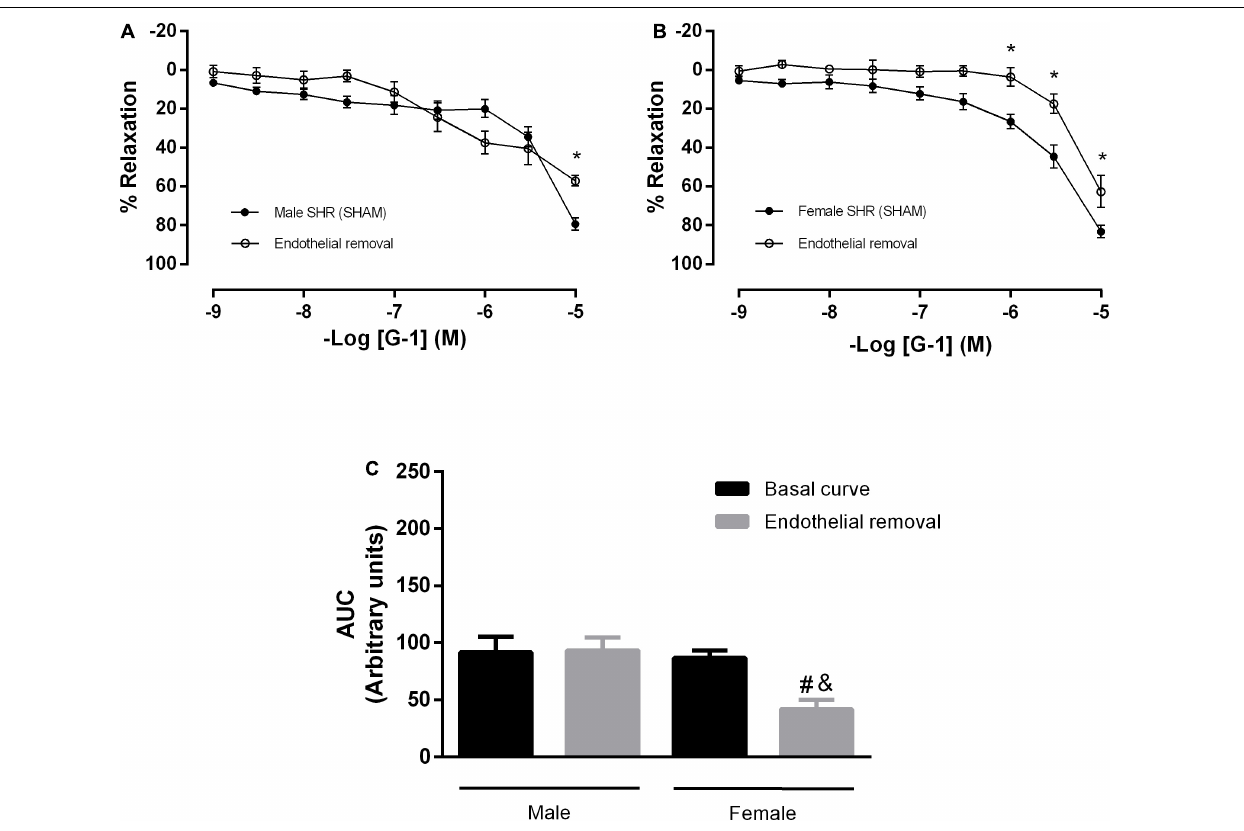
FIGURE 2 | The vasodilator response induced by G-1 is partially dependent on the endothelium in female SHR. Effect of endothelial removal on the relaxation response in (A) Male ( n = 5) and (B) Female ( n = 6) SHR groups. (C) Area under the curve (AUC) before and after endothelial removal. Values are expressed as mean ± SEM. * P < 0.05 compared to the same dose in the control curve, # P < 0.05 compared to the AUC of the Female SHR control curve and & P < 0.05 compared to the AUC of the Male SHR group after endothelial removal. The curve analysis was carried out point-by-point through two-way ANOVA, followed by the Sidak post hoc test. AUCs were evaluated through one-way ANOVA followed by Tukey post hoc test.